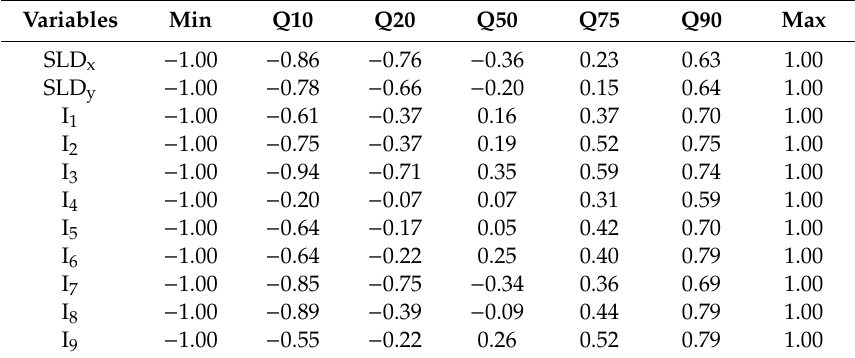
Table 5. Intensity of input variables for sensitivity analysis in the normalized